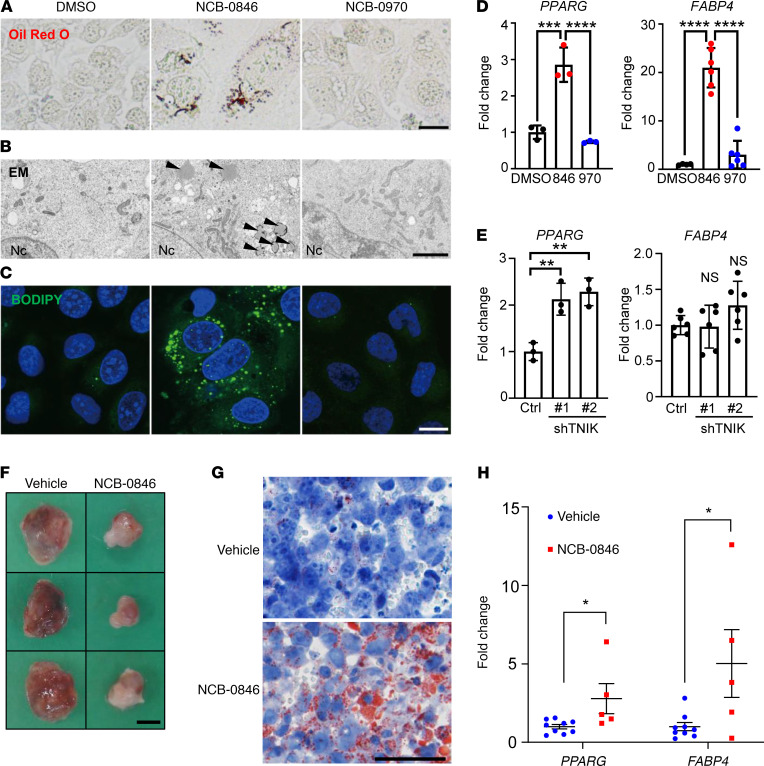
Conversion of OS cells to adipocyte-like cells through TNIK inhibition.(A–C) U2OS cells were treated with DMSO, 1 μM NCB-0846, or 1 μM NCB-0970 for 3 days, and intracellular lipid droplets were visualized by (A) Oil red O staining, (B) electron microscopy (EM), and (C) fluorescent molecular probe BODIPY labeling. Nc, nucleus. Arrowheads indicate lipid droplets. Scale bar: 20 μm (A and C); 3 μm (B). (D) U2OS cells were treated with DMSO, 1 μM NCB-0846, or 1 μM NCB-0970 for 3 days, and expression of the PPARG (n = 3, respectively) and FABP4 (n = 4 for DMSO and n = 6 for NCB-0846 and NCB-0970) genes (normalized to ACTB) was quantified by RT-PCR. Data represent the mean ± SD. One-way ANOVA, **P < 0.01, ****P < 0.0001. (E) Expression of the PPARG (n = 3) and FABP4 (n = 6) genes (normalized to ACTB) in U2OS cells stably expressing control shRNA or shTNIK was quantified by RT-PCR. Data represent the mean ± SD. One-way ANOVA, **P < 0.01. (F) Representative images of the macroscopic appearance of NOS-10 xenografts resected from mice administered vehicle or NCB-0846 HCl (90 mg/kg) for 10 days. Scale bar: 5 mm. (G) Oil red O staining for NOS-10 xenografts resected from mice administered vehicle or NCB-0846 HCl (90 mg/kg) for 10 days. Scale bar: 50 μm. (H) Expression of the PPARG and FABP4 genes (normalized to ACTB) in NOS-10 xenografts resected from mice administered vehicle (n = 9) or NCB-0846 HCl (n = 5) for 10 days. Student’s t test, *P < 0.05. Data represent the mean ± SEM.